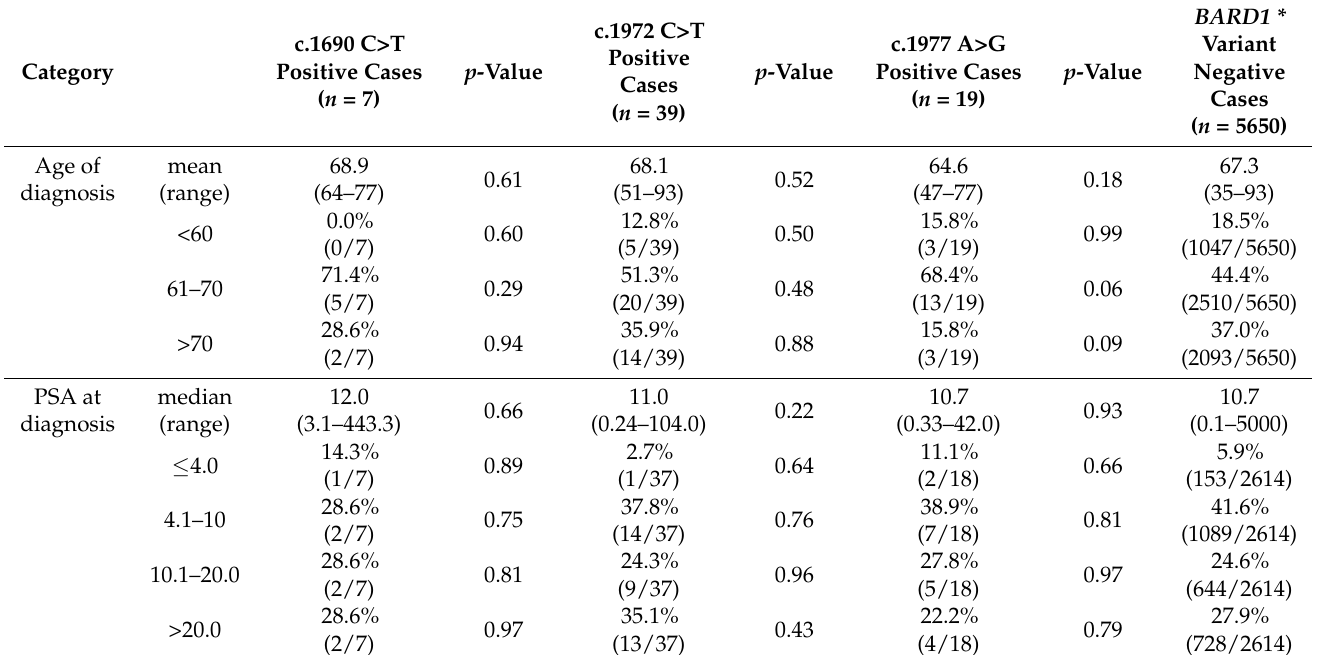
Table 2. Characteristics of patients with prostate cancer who carry a BARD1 variant (7 patients with c.1690C>T, 39 patients with c.1972C>T and 19 men with c.1977A>G) compared to BARD1 variant-negative prostate cancer cases (5650